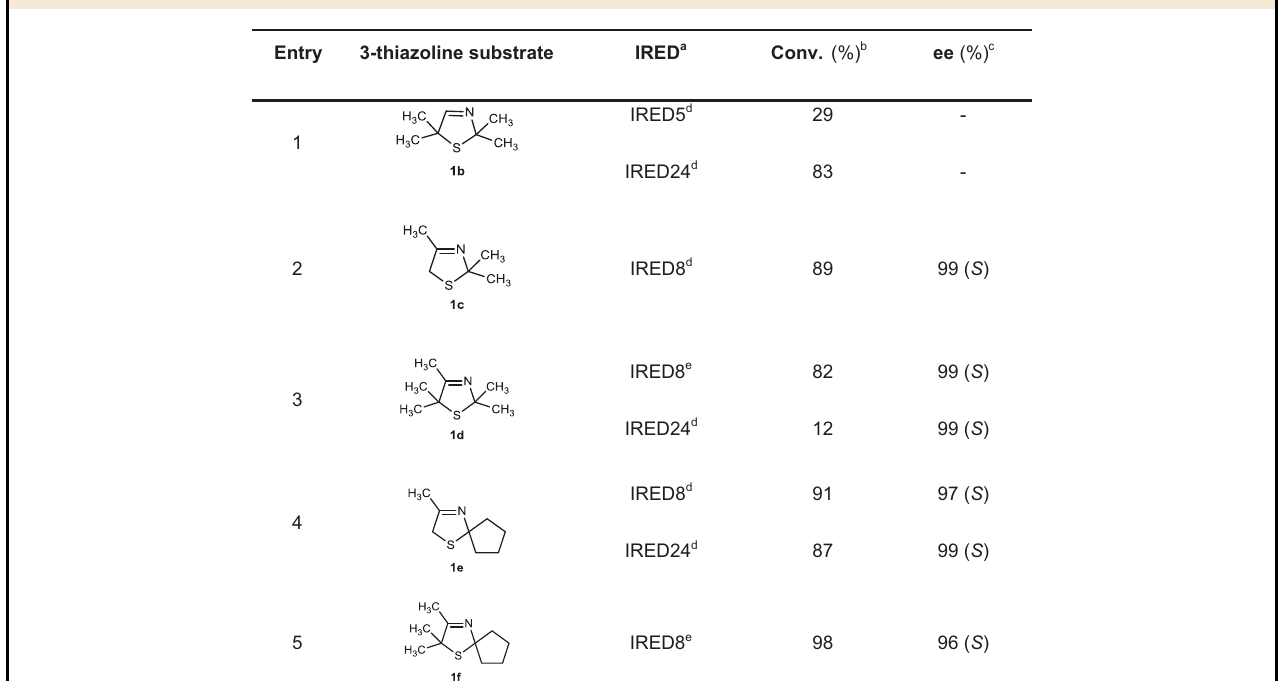
Table 1 Reduction of 3-thiazolines using imine reductases